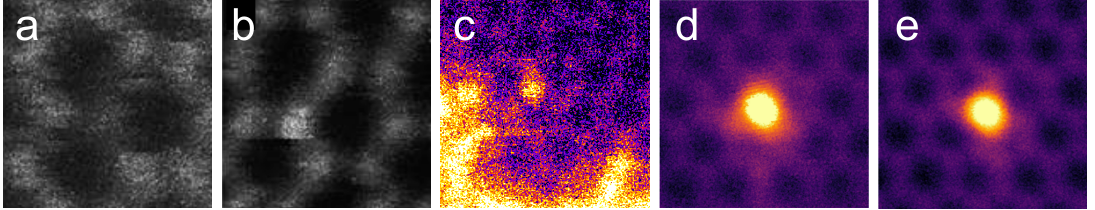
Figure 7. Ion-implanted impurity atoms in graphene, as imaged with scanning transmission electron microscopy. Due to the atomic-number dependent contrast, lighter atoms appear dark and heavier bright. ( a ) Boron (dark atom) implanted at 25 eV and ( b ) nitrogen (bright atom) implanted at 25 eV. Both images adapted with permission from Ref. [87], Copyright (2013) American Chemical Society. ( c ) Phosphorus (bright atom) implanted at 30 eV. The bright area at the bottom and on the left is caused by carbon-based contamination on graphene. Adapted from Ref. [92], licensed under a Creative Commons Attribution 3.0 License. ( d , e ) Three- and fourfold-coordinated implanted germanium atoms. Implantation energy was 20 eV. Reprinted with permission from Ref. [93]. Copyright (2018) American Chemical